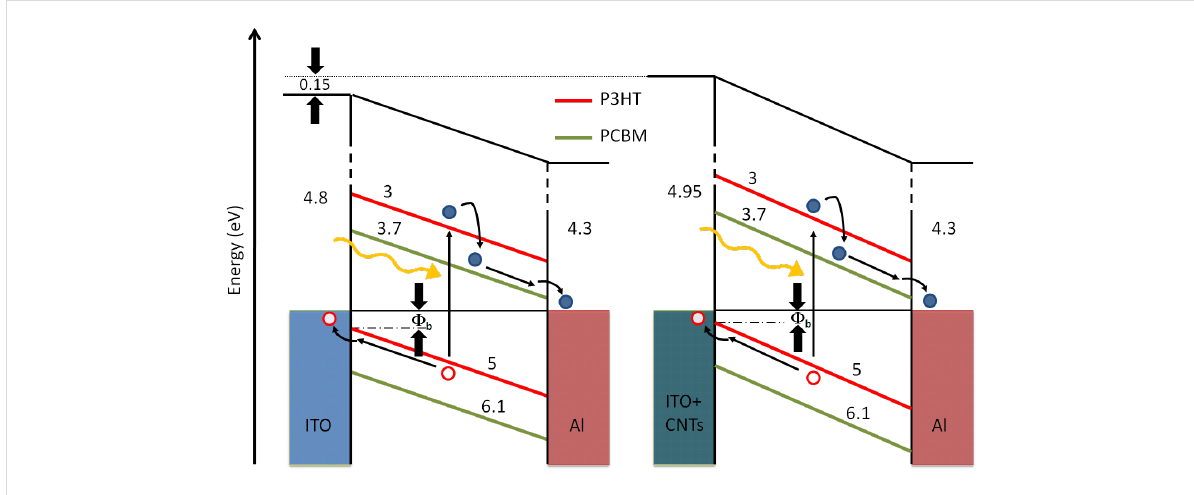
Figure 4: WF levels for cells with ITO (left) and ITO–CNT (right) electrode. (All reported values are in eV and negative).